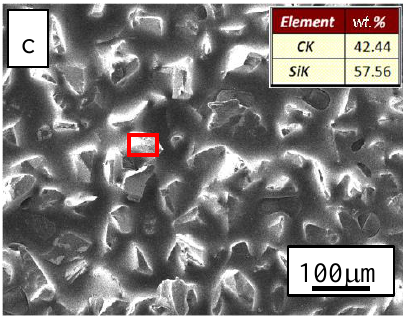
Figure 4. The morphologies of the 180-mesh SiC and SiO 2 abrasives: ( a ) SiC; ( b ) SiO 2 , and ( c ) SiC